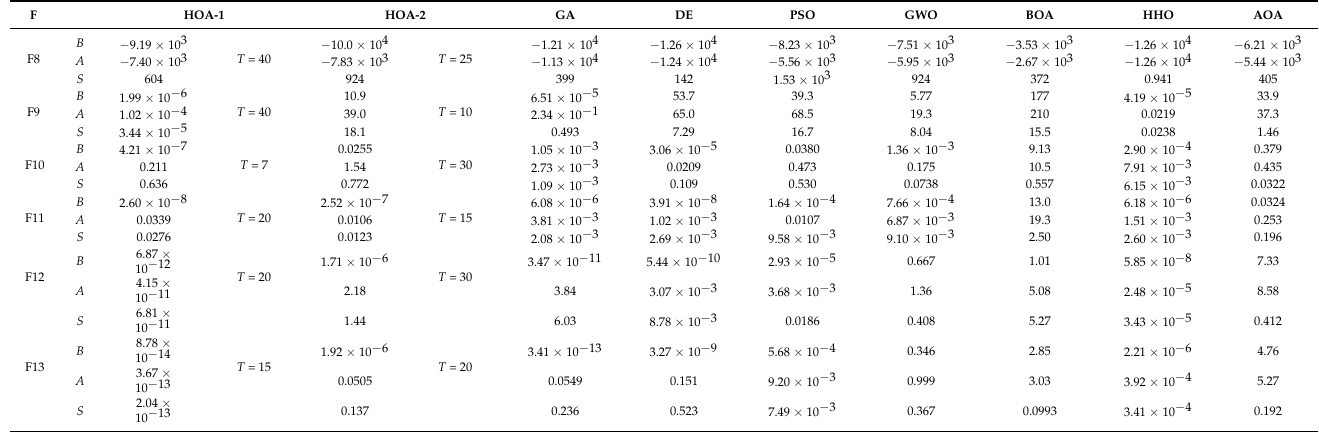
Table 3. Results of multimodal benchmark functions.